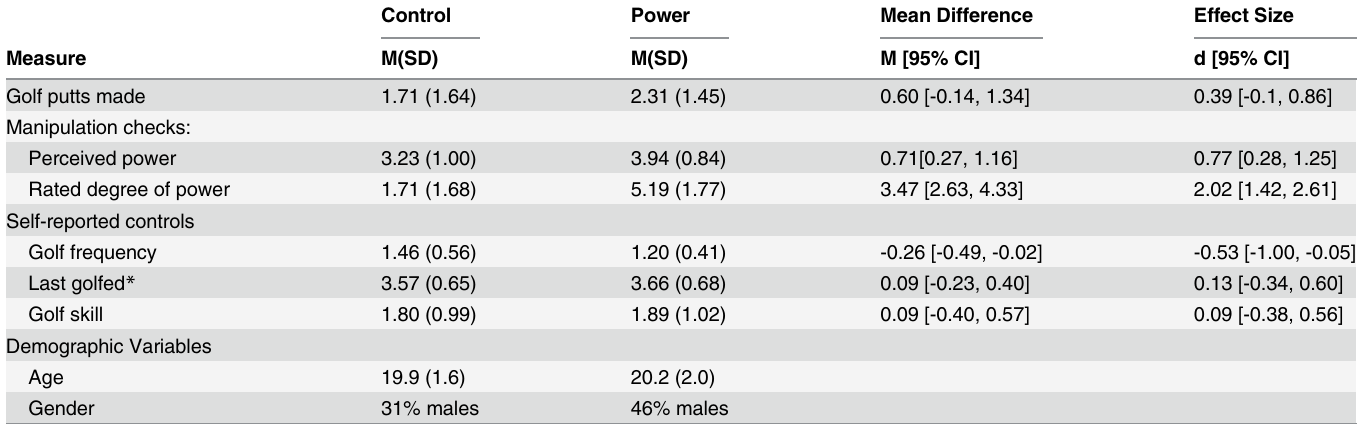
Table 2. Experiment 2: Summary of Group